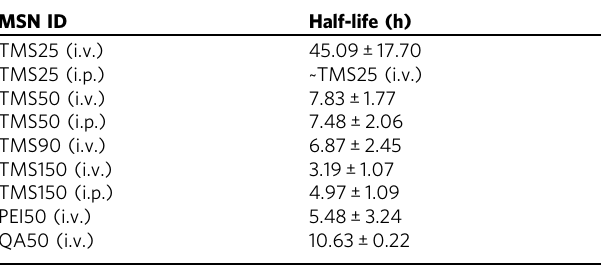
Data represent mean±s.d., n = 4 (except TMS50 (i.p.) and TMS25 (i.p.), where n = 3). Note: for TMS25 (i.p.), t 1 /2 is not available because an elimination phase was absent in its concentration – time pro fi le within the timeframe of study (see dotted black curve in Fig. 4a), but its t 1/2 may be comparable to the value for TMS25